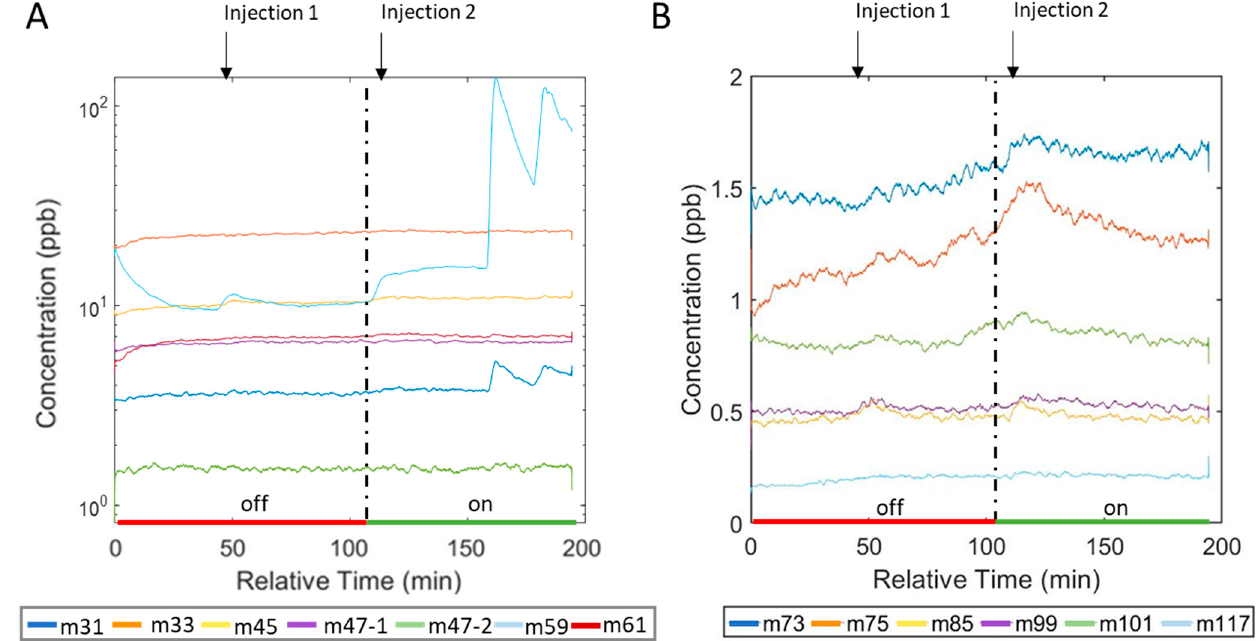
Figure A7. Evolution of the concentration of several VOCs of interest as potential byproducts of limonene oxidation from low molecular weight (panel ( A )) to higher molecular weight (panel ( B )) as a function of the time during the perturbation test presented in Figure 12 (injection of limonene) when the air cleaner was off and when the air cleaner was on.